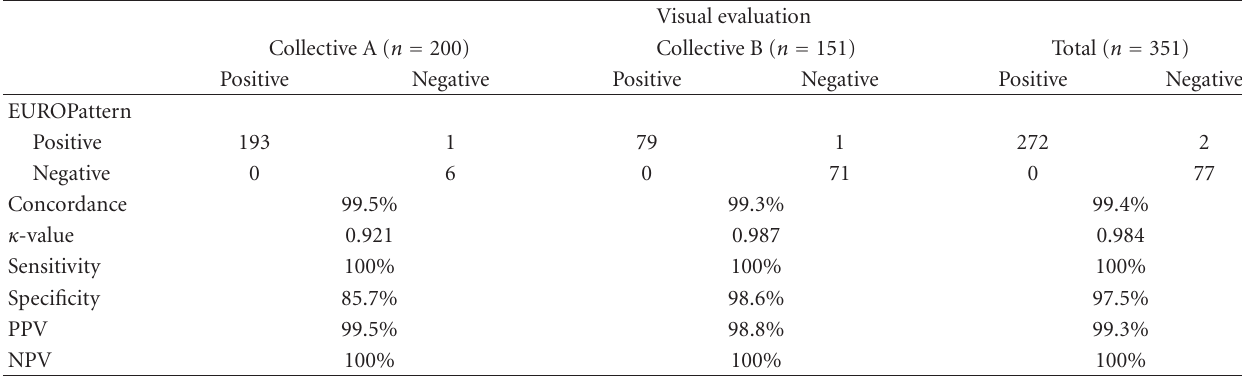
Table 1: Comparison of software-based and visual positive/negative classification.